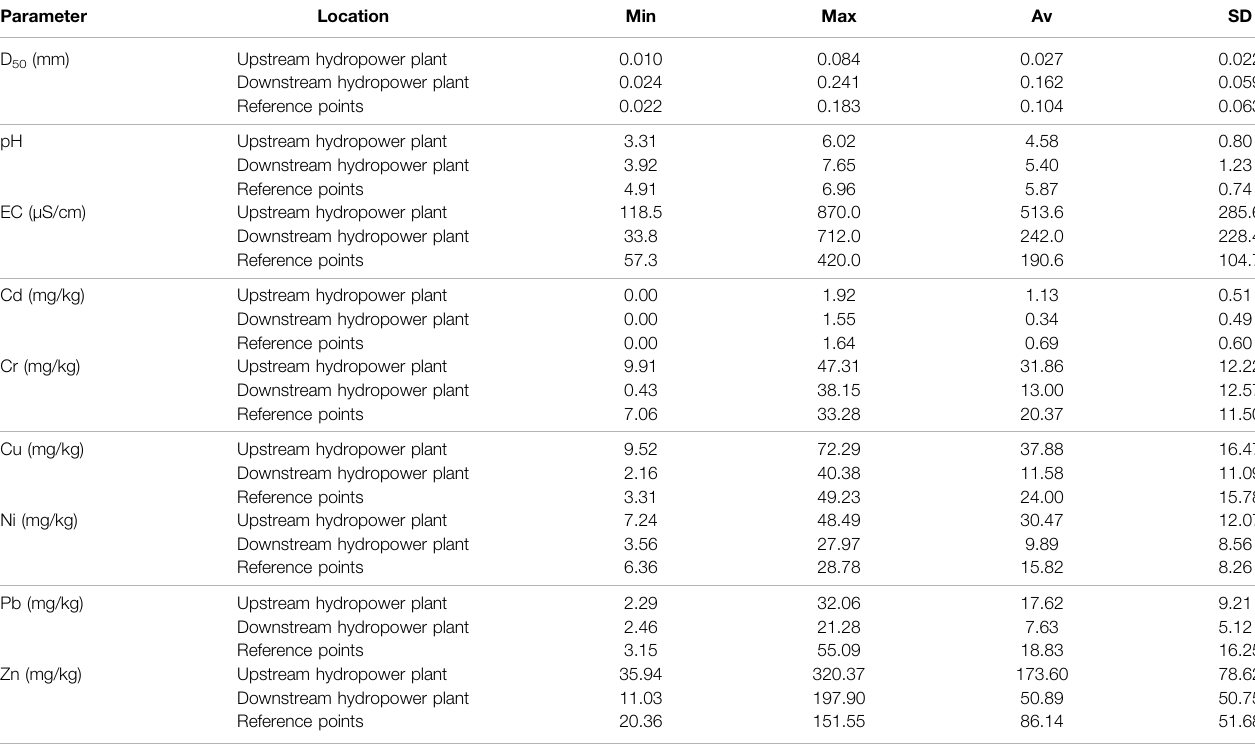
TABLE 3 | Basic statistics of the results obtained for the tested parameters in the sediments of the Bystrzyca River. Parameter